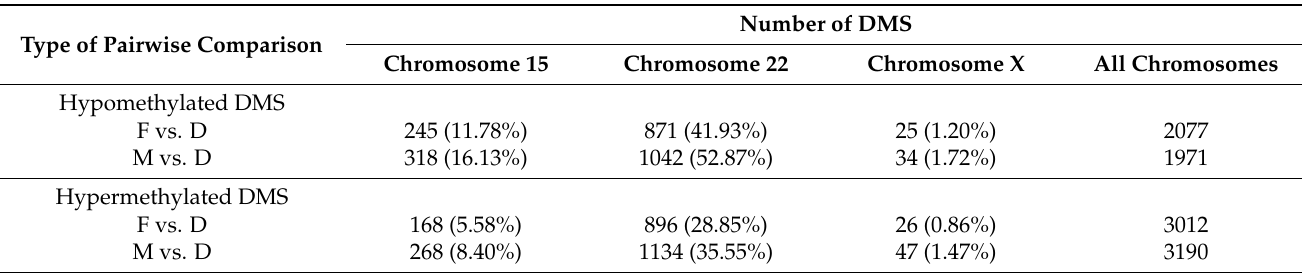
Table 4. The pairwise comparisons of the RRBS datasets and DMS methylation trends in the whole genomes and within the selected chromosome regions (explained in the text). Abbreviations: F—father, M—mother, D—daughter.